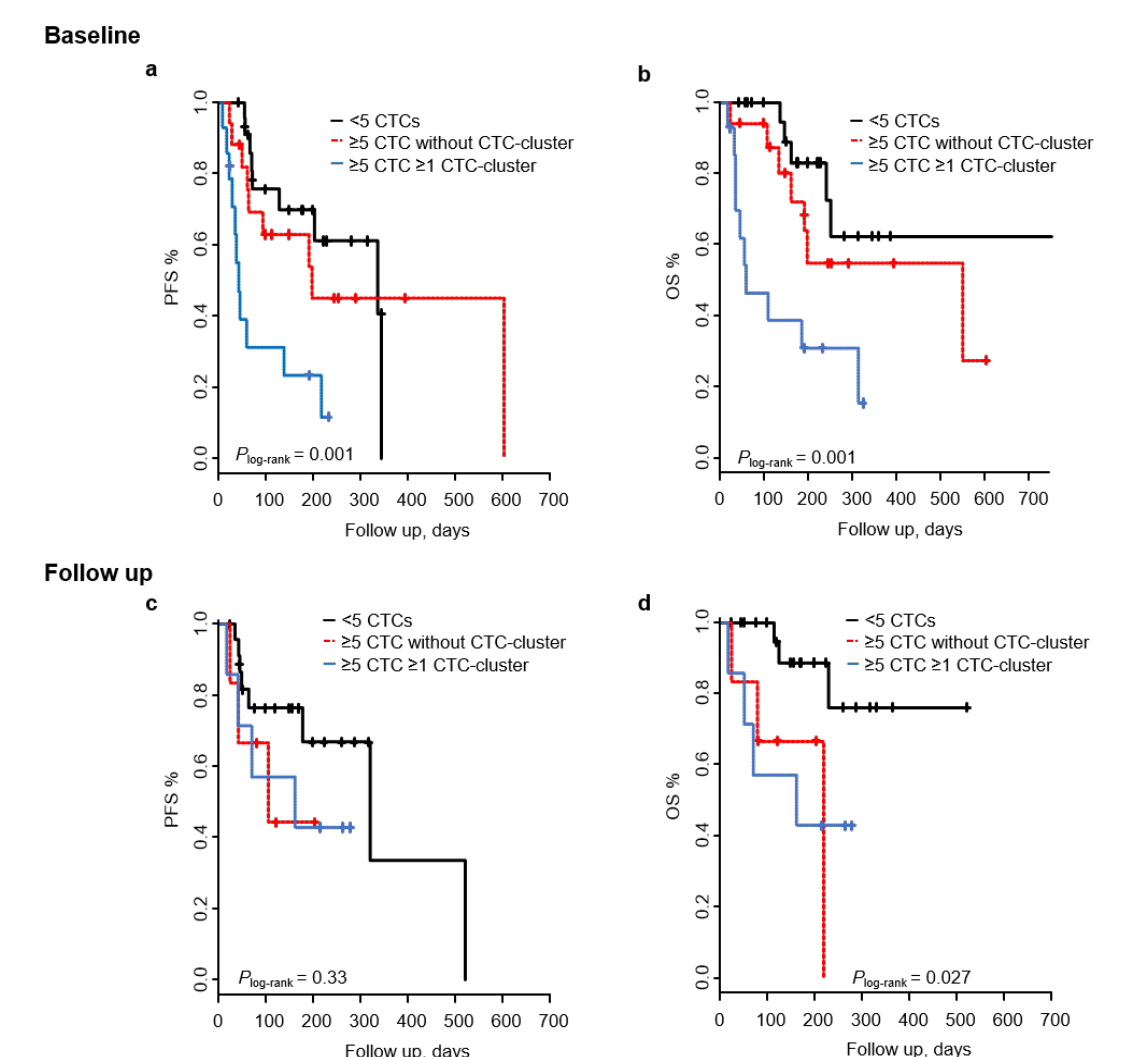
Figure 3. Risk groups regarding PFS and OS based on CTC count and CTC-clusters. Kaplan–Meier curves displaying PFS and OS of patients with <5 CTC, patients with ≥5 CTCs without CTC-clusters and patients ≥5 CTCs with CTC-clusters at baseline ( a, b ) and follow up ( c, d ).